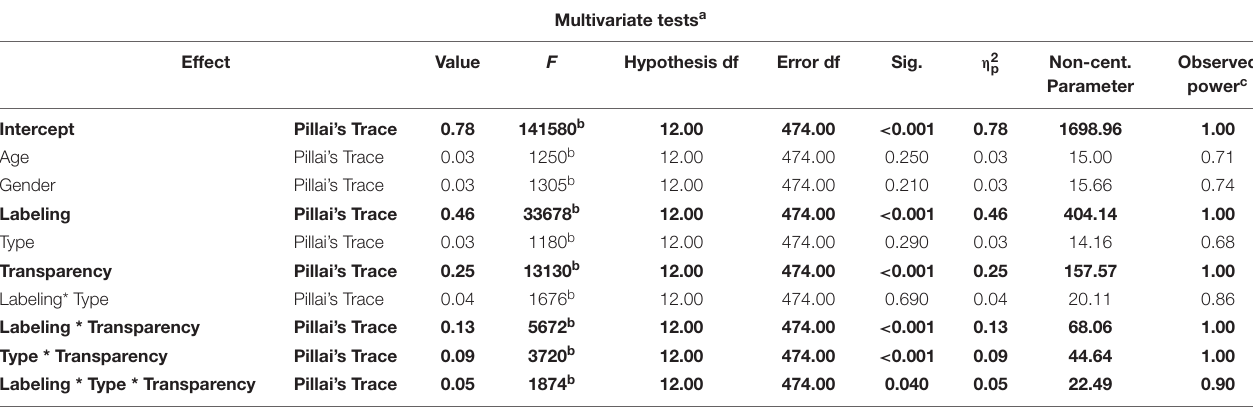
TABLE 3 | Summary of the results of the multivariate test, considering all combinations of packaging factors (type – bag vs. jar, transparency – transparent vs. opaque, labeling – with vs. without label), and including controls for gender and age (only Pillai’s trace test being reported). Multivariate tests